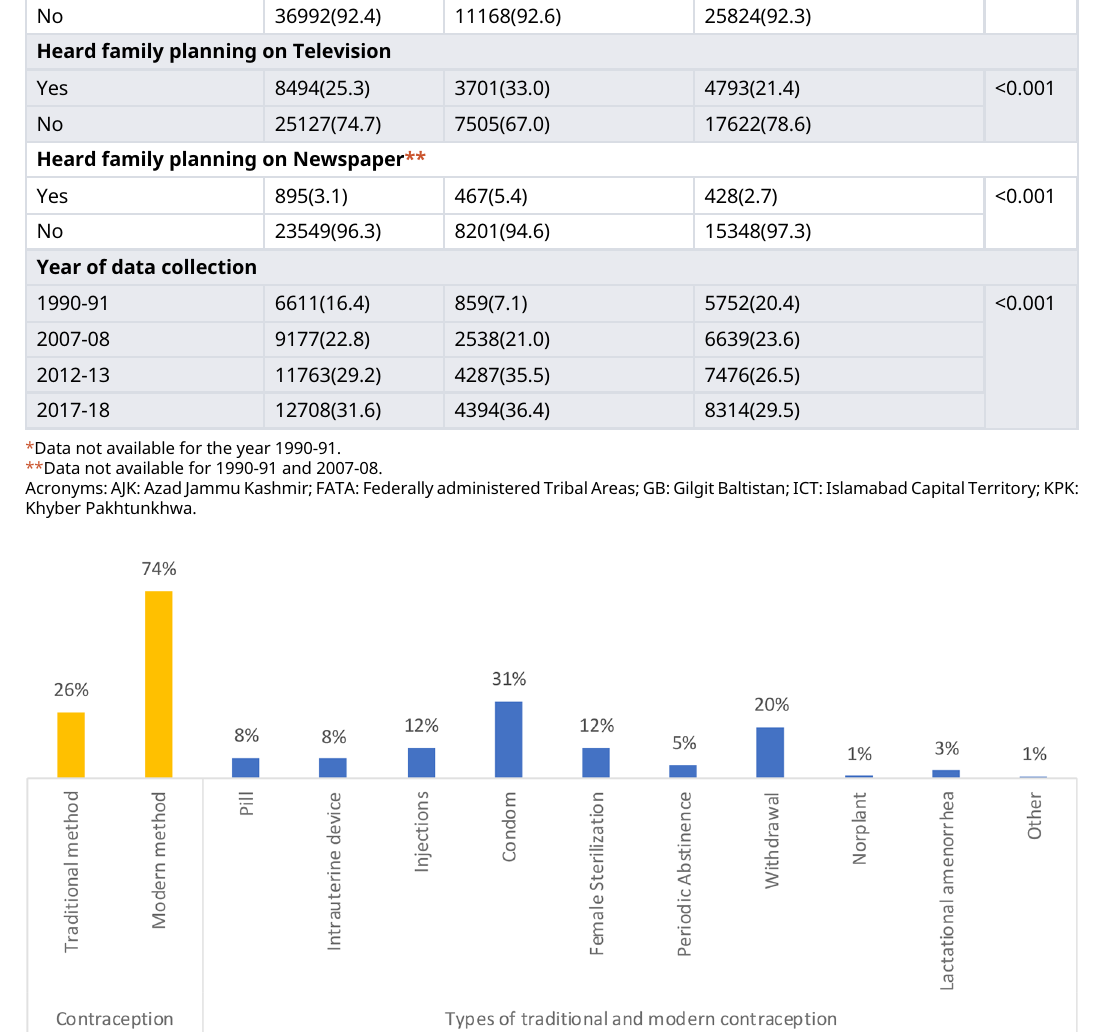
Figure 1. Percentage of users by type of method used at the time of the survey,